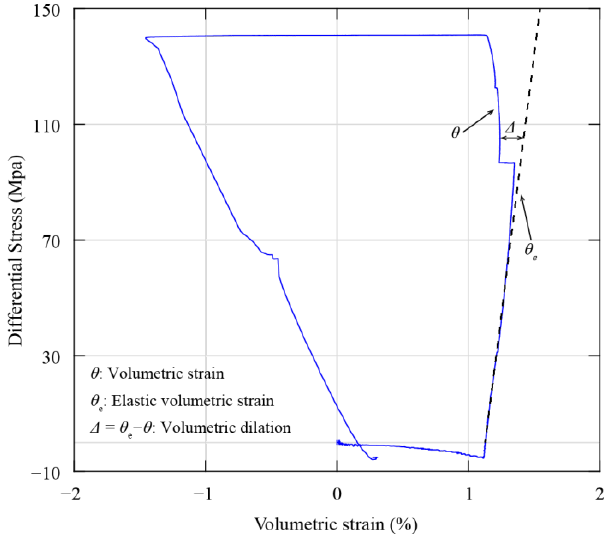
Figure 4. Volumetric strain varied with the differential stress.